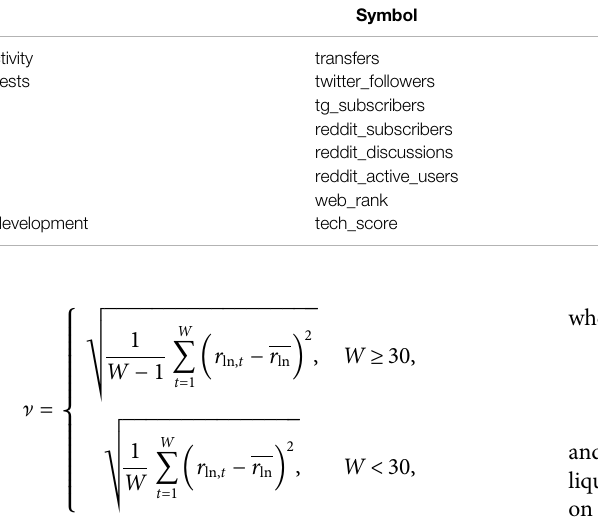
TABLE 1 | Descriptions of the control variables.